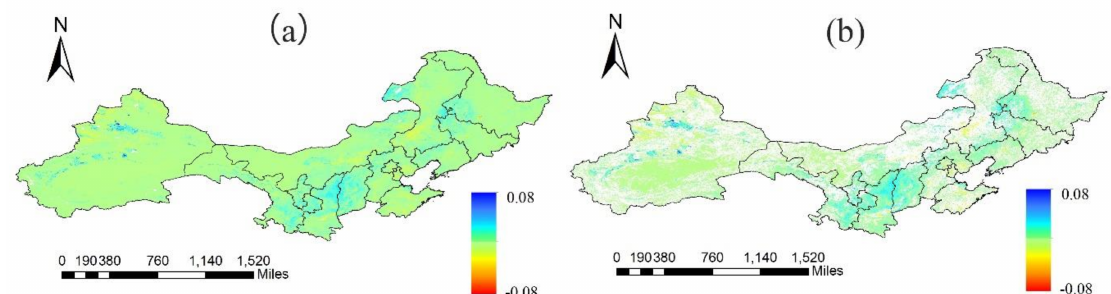
Figure 6. ( a ) The temporal trends of annual averaged FVC of four data sets in northern China during the period 2001–2012. ( b ) The temporal trends of annual averaged FVC of four data sets that passed the significant test in northern China during the period 2001–2012. Table 3. Statistics for the percentage of significant level of FVC change during the period 2001–2012. Regions Significantly Increased No Significant Change Significantly Decreased Northern china 33.03% 50.16% 16.81% Northeast china 44.88% 50.12% 5.00% Northwest china 23.34% 51.86% 24.80% North China 56.05% 35.59%